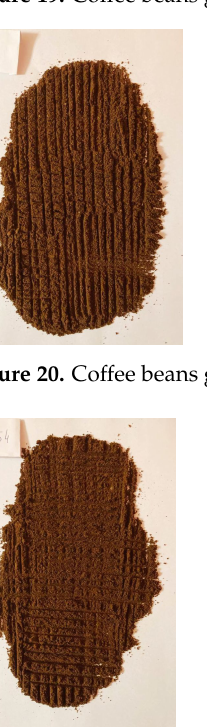
Figure 19. Coffee beans ground for about 20 s.